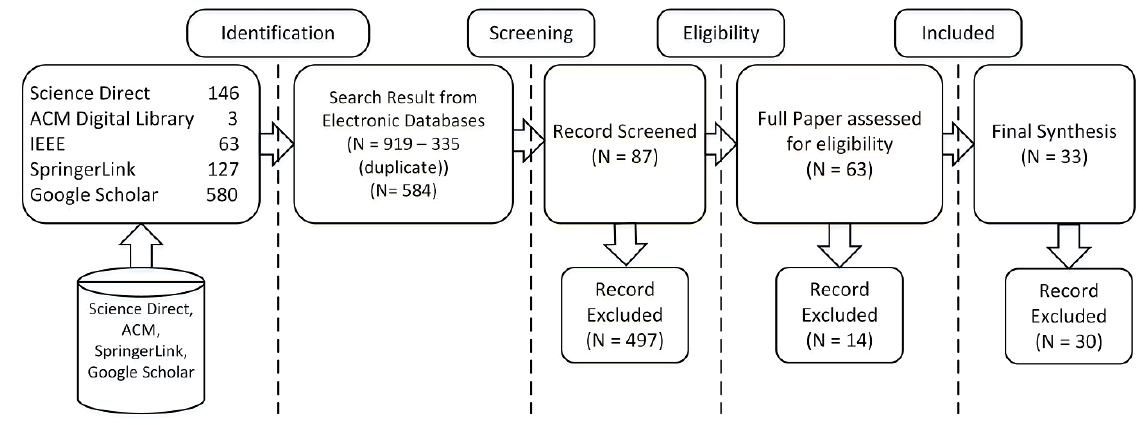
Figure 2. The research workflow is adapted from PRISMA (1a).